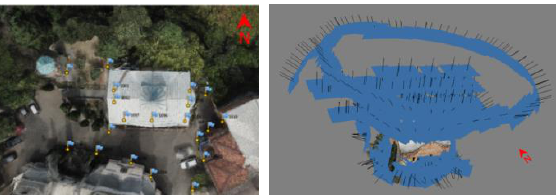
Figure 8. Views of a reduced dense point cloud after faulty automatic orientation in PhotoScan 1.4.1; left: faulty orientation with double reconstruction and rotation; right: front view of the church with double reconstruction of the entrance portal